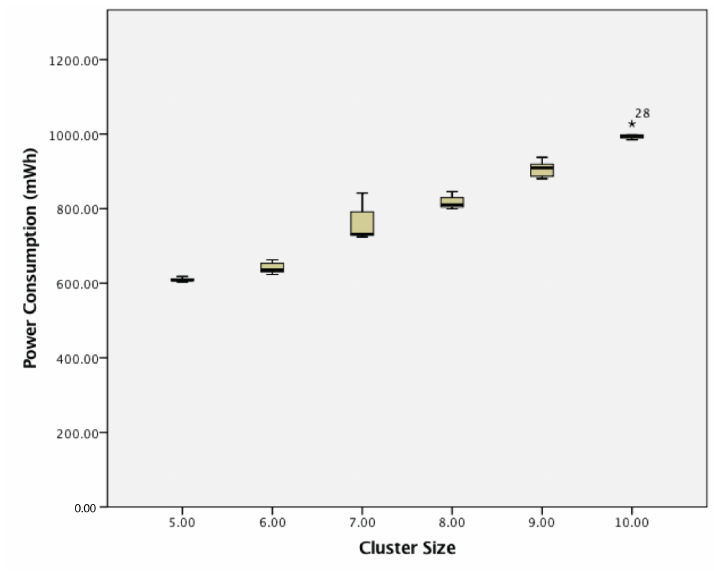
Figure 15. Power consumption of a cluster of 5–10 passive wireless sensor nodes with a 10 s transmission